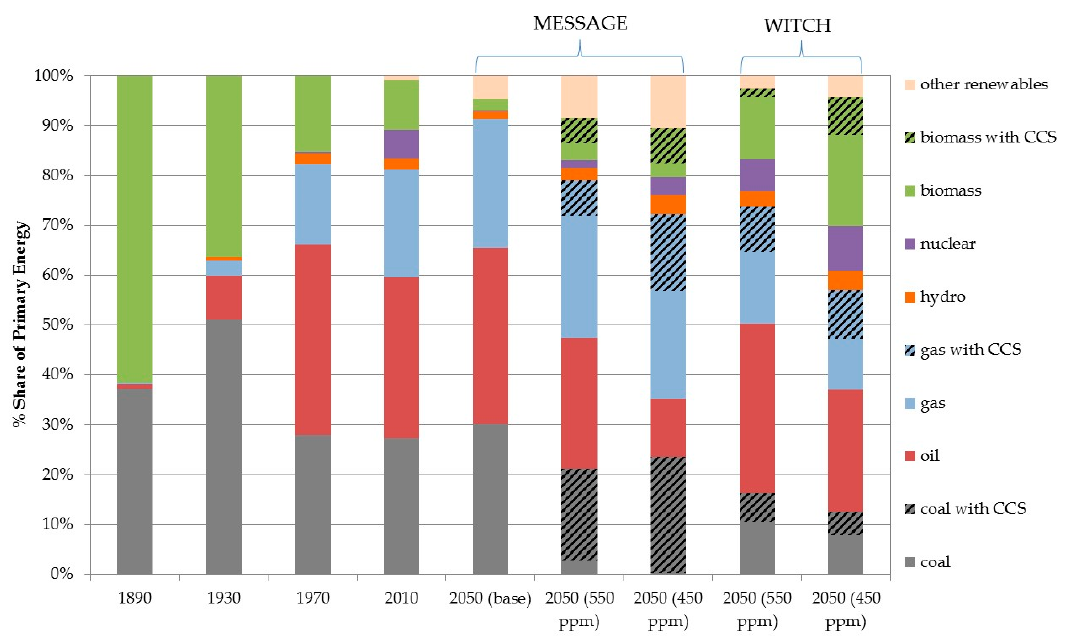
Figure 1. Historical, current, and projected mix of global primary energy at 40 year intervals. Notes: 1890–1970 data from Smil (2010) [11], 2010 data from IEA (2012) [12], 2050 data from Ampere project inter-model comparison (from IPCC AR5 scenario database).